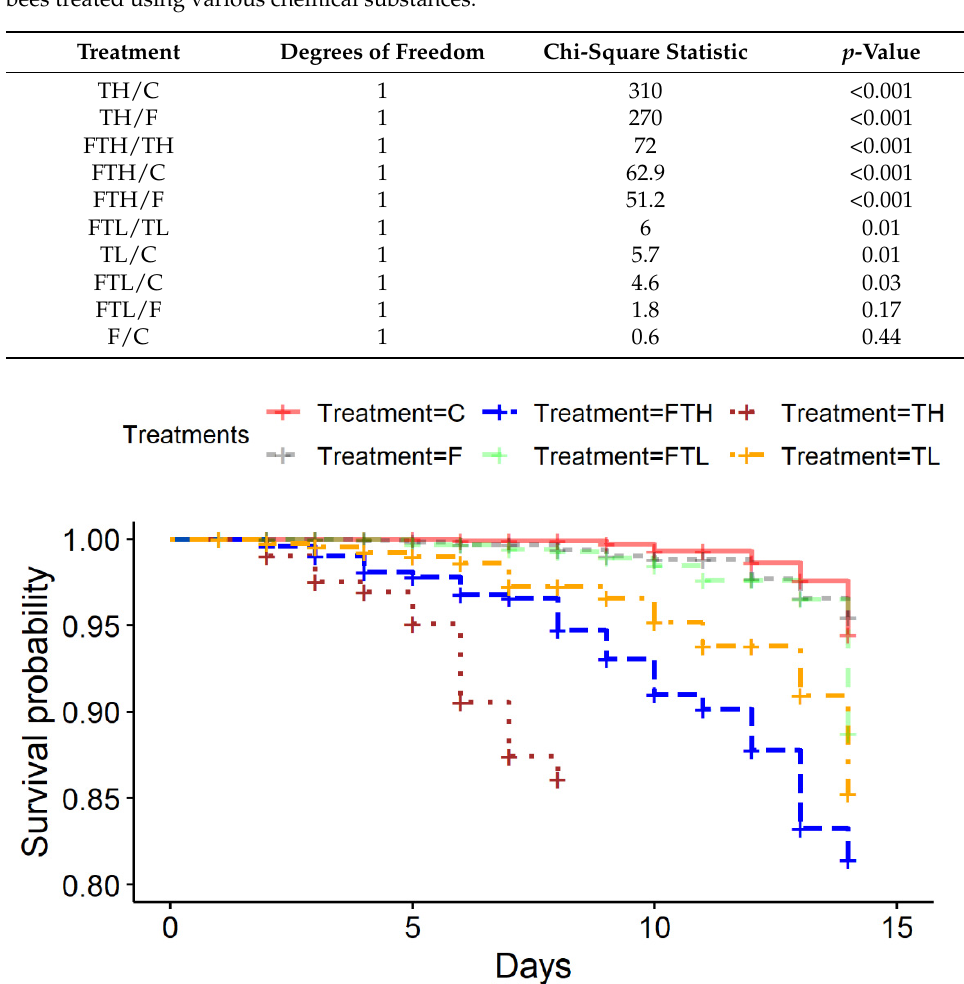
Figure 1. The relationship between the bee mortality and the treatments over 14 days (Kaplan-Maier survival analyses). Legend: TH—sucrose solution (50% w/v ) with high dosage of Thiacloprid (70 mg/L), FTH—sucrose solution (50% w/v ) with a mixture of phenolic compounds and a high dosage of Thiacloprid (70 mg/L), TL—sucrose solution with a low dosage of Thiacloprid (35 mg/L), FTL—sucrose solution (50 w/v ) with a mixture of phenolic compounds and low dosage of Thiacloprid (35 mg/L), F—sucrose solution (50% w/v ) and a mixture of phenolic compounds, C—sucrose solution (50% w/v ). Table 3. The results of the log-rank test, which was used to compare different treatment groups of bees treated using various chemical substances.